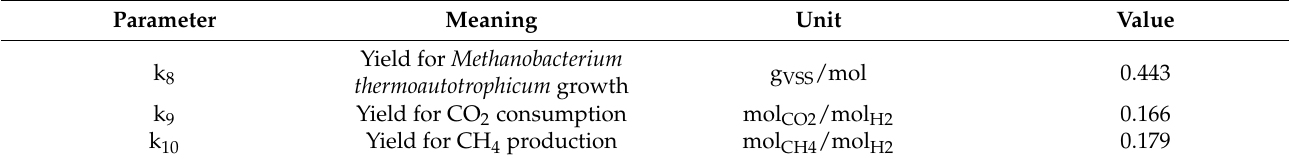
Table 3. Yield parameters of the Methanobacterium thermoautotrophicum bacteria metabolism.